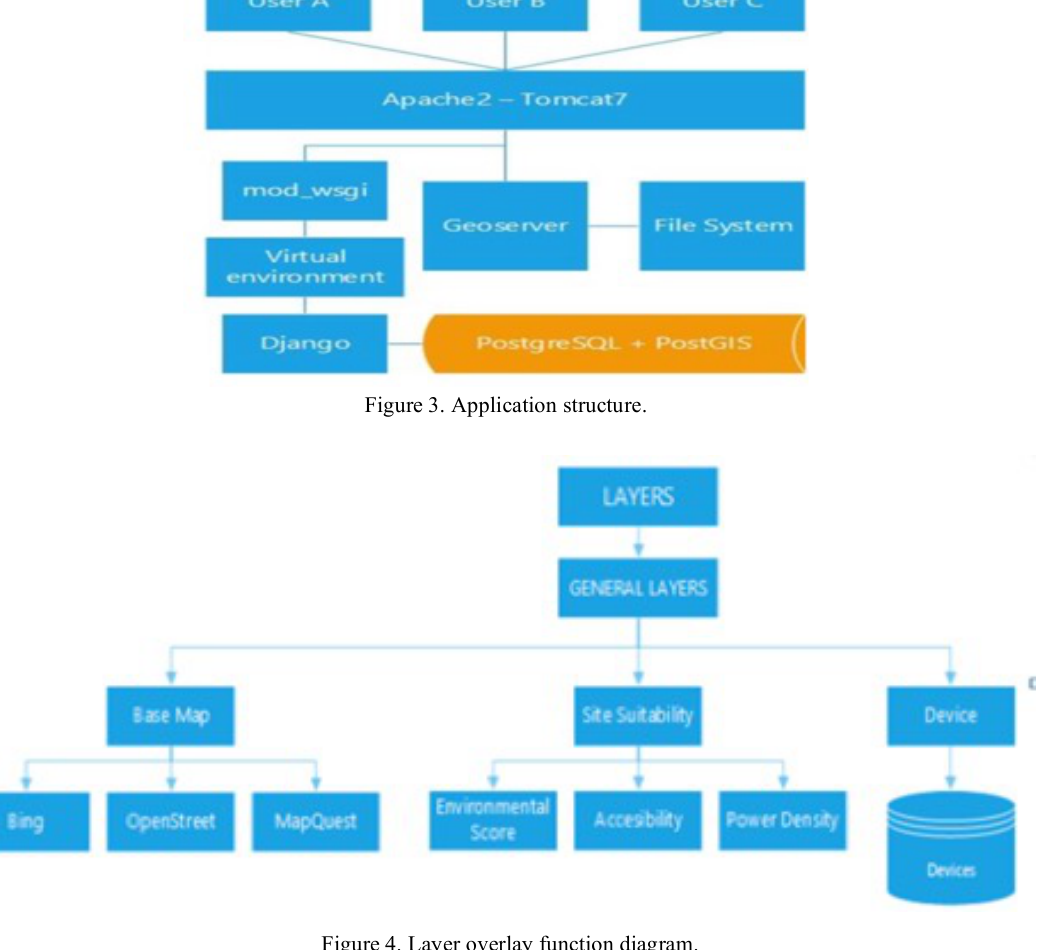
Figure 4. Layer overlay function diagram.